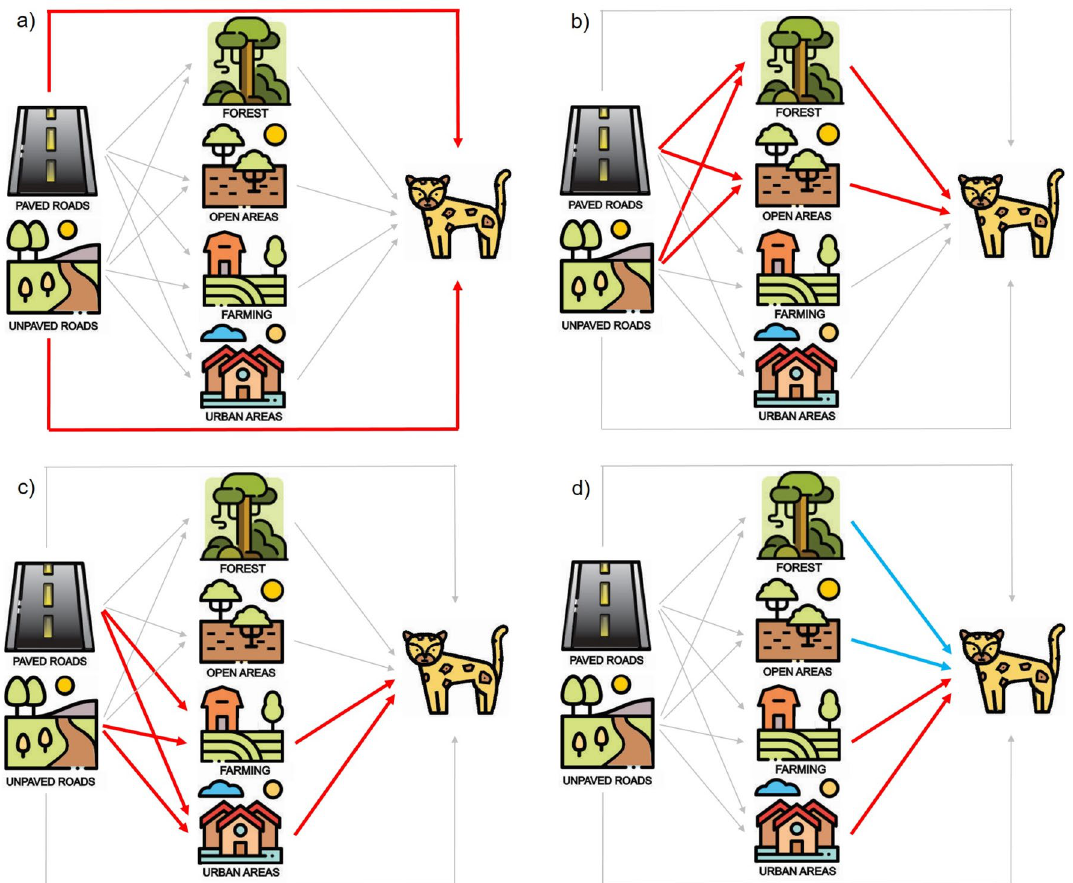
arrows denote expected positive (blue) or negative (red) effects of variables on jaguars’ space use. Direct effects of variables on jaguars’ space use are depicted by solid arrows, while indirect effects are depicted by